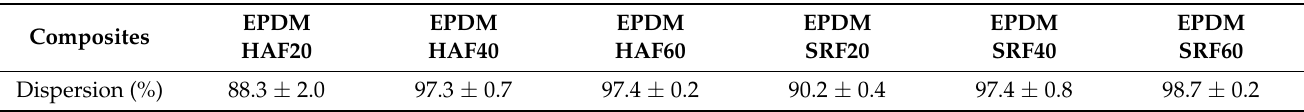
Table 1. Dispersion degree of peroxide-crosslinked EPDM rubber composites blended with HAF CB and SRF CB